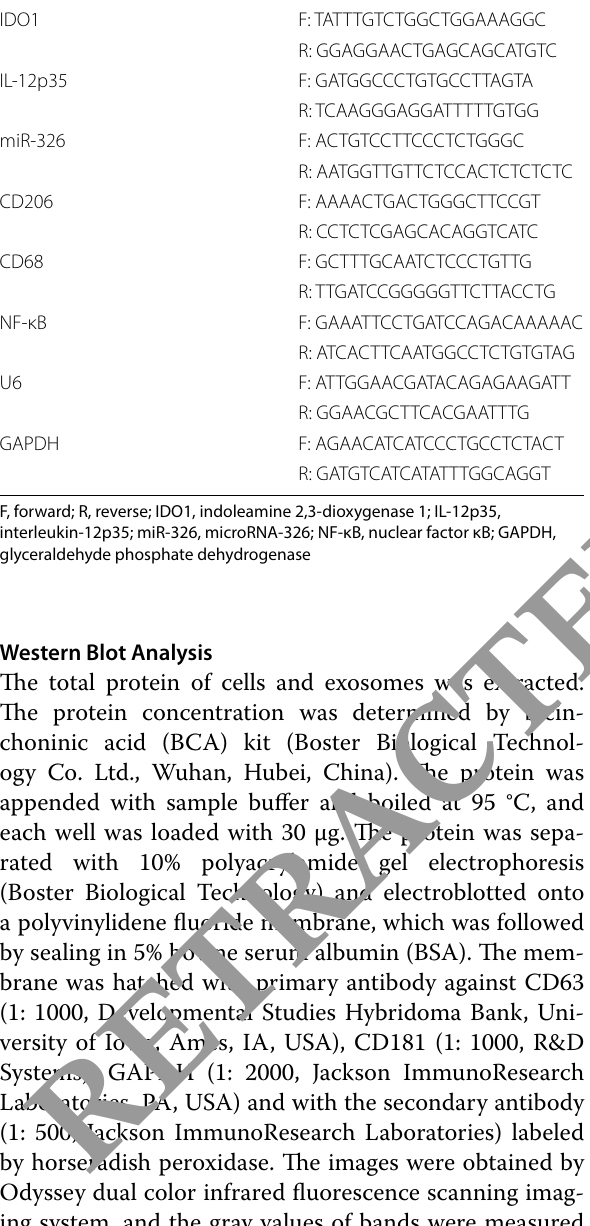
Table 1 Primer sequence Gene Sequence (5 ′ –3 ′